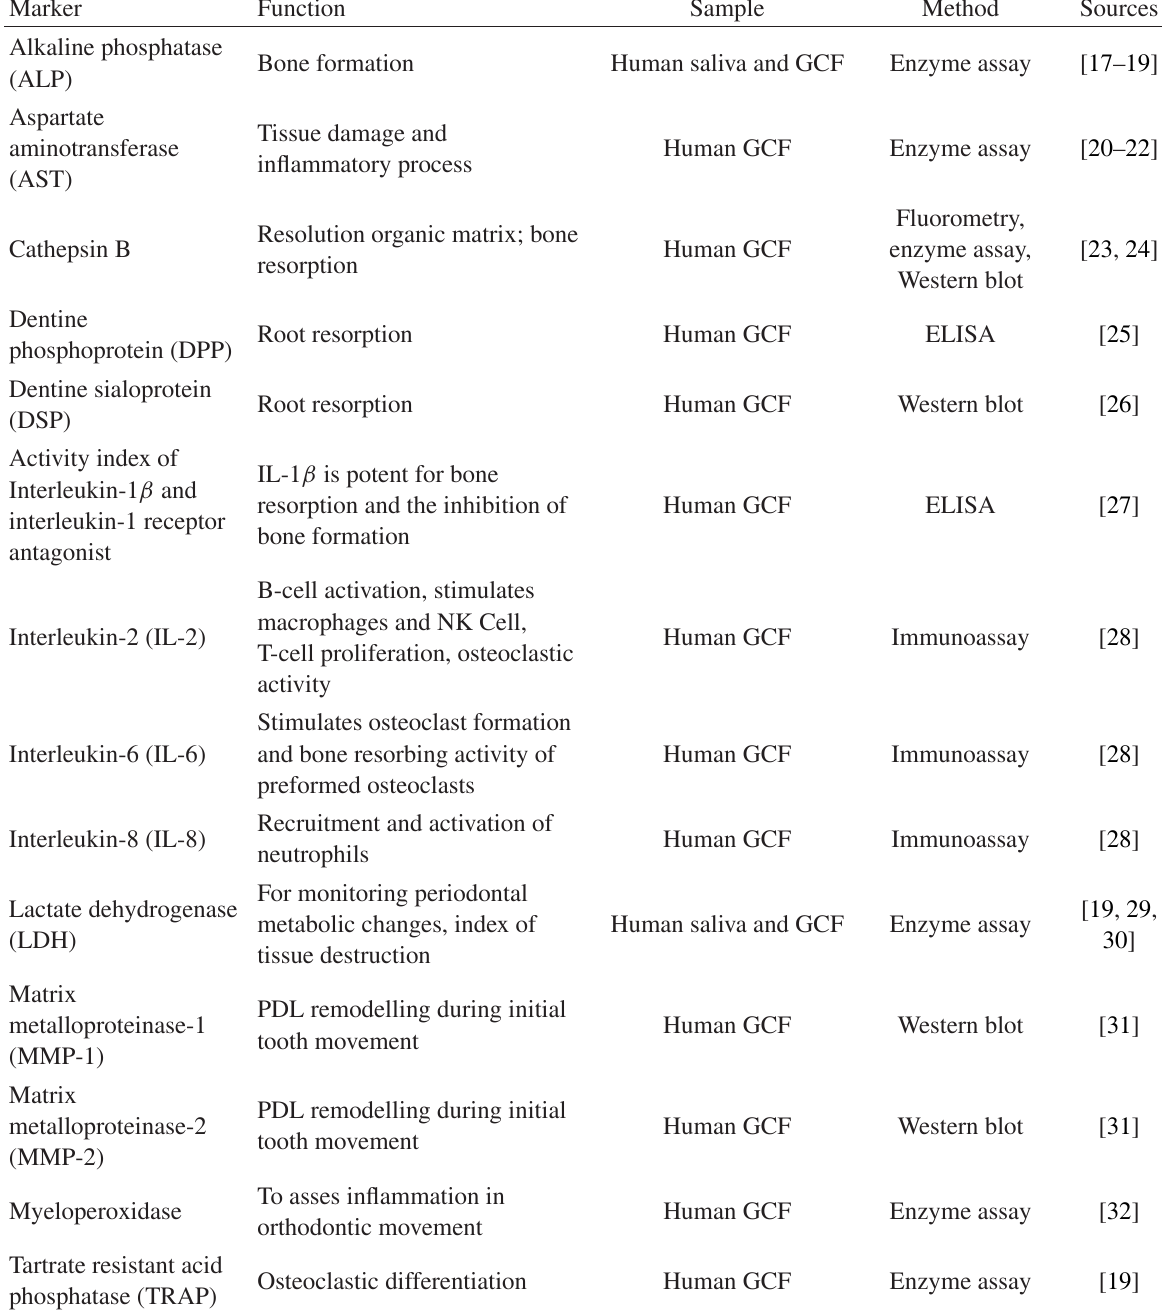
TABLE 3: Markers involved in orthodontic tooth movement collected from GCF and